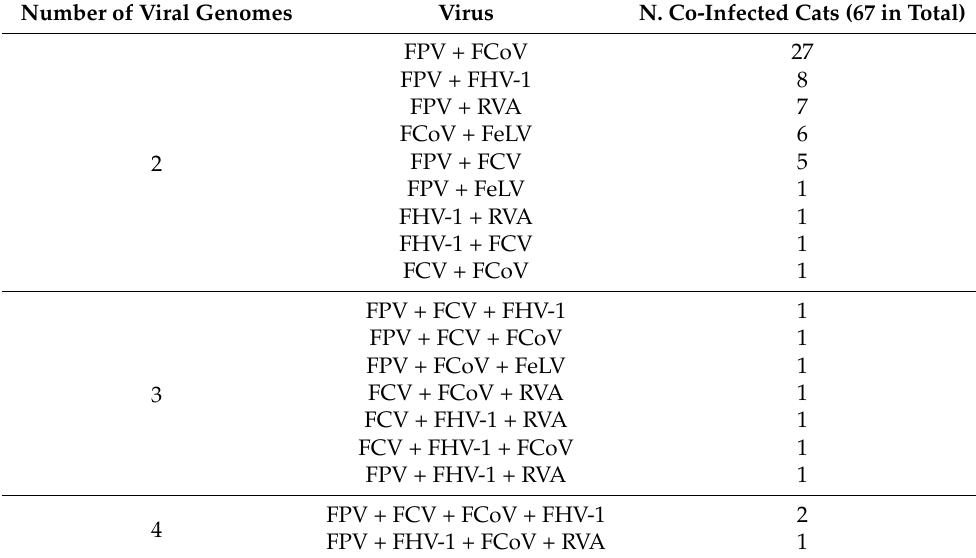
Table 2. Viral genomes simultaneously present in the same animal.